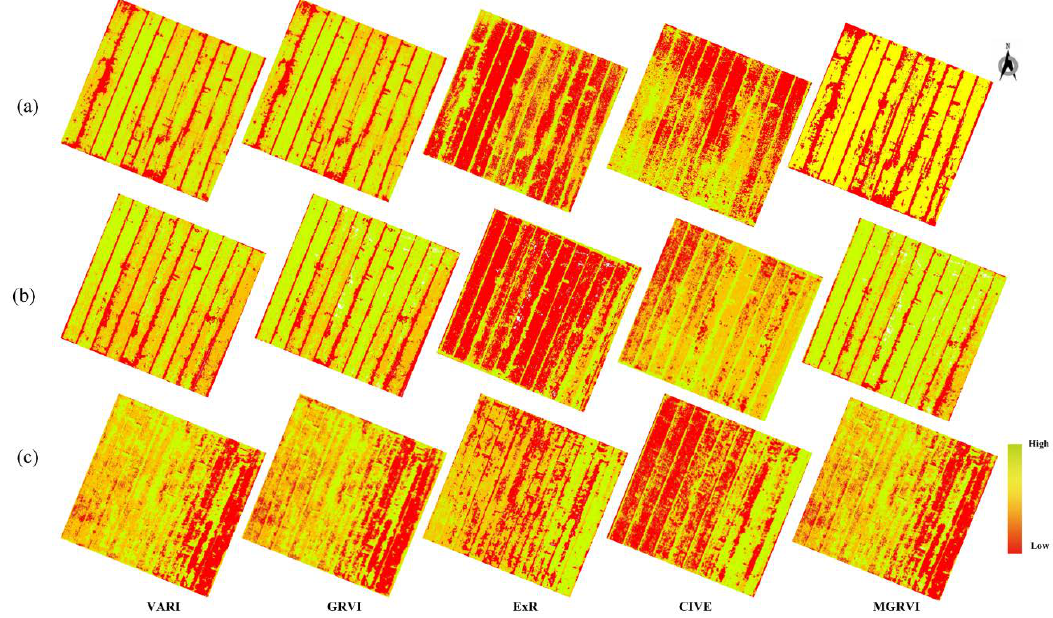
Figure 3. Spatial distribution of key vegetation indices at different periods. ( a ) Flowering, ( b ) Filling, and ( c ) Maturity and ( c ) Maturity stages.